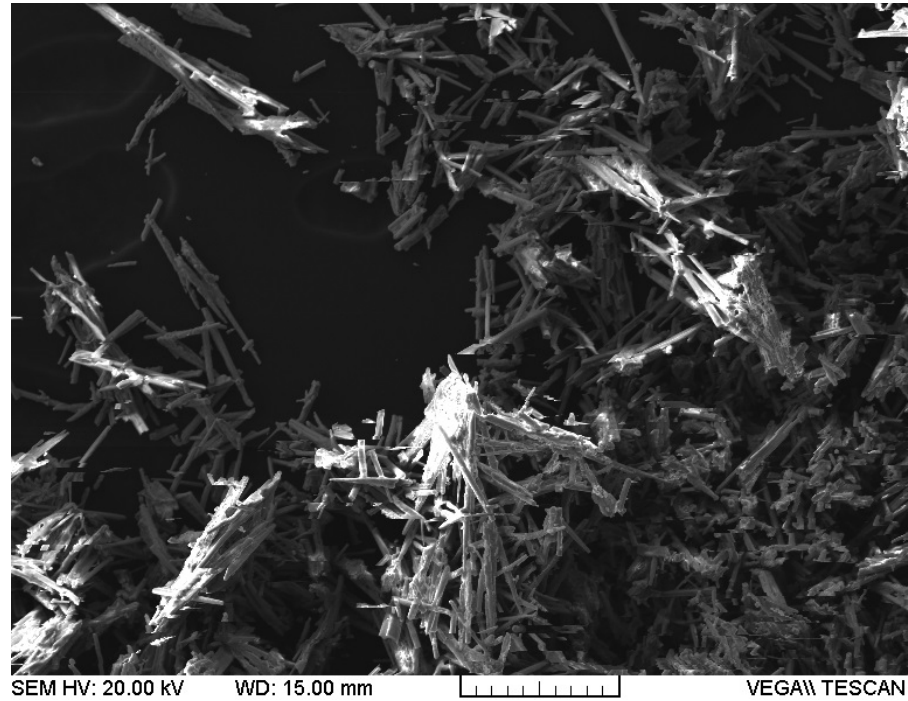
Figure 1. SEM morphology of the LiZn(IO 3 ) 3 powder. The ruler in the bottom part corresponds to 100  m (10 